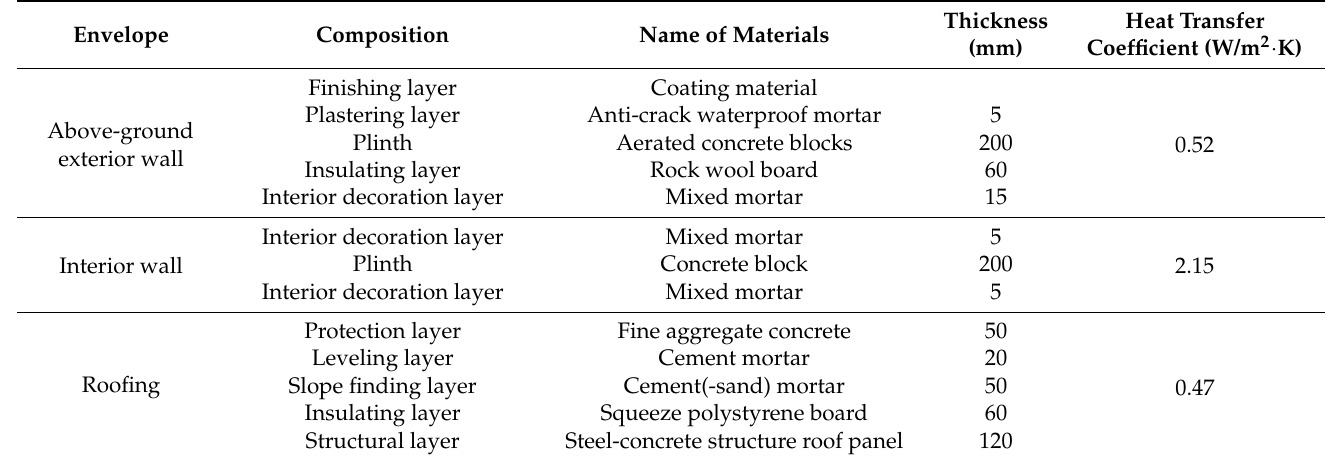
Table 5. Composition and heat transfer coefficient of the envelope.